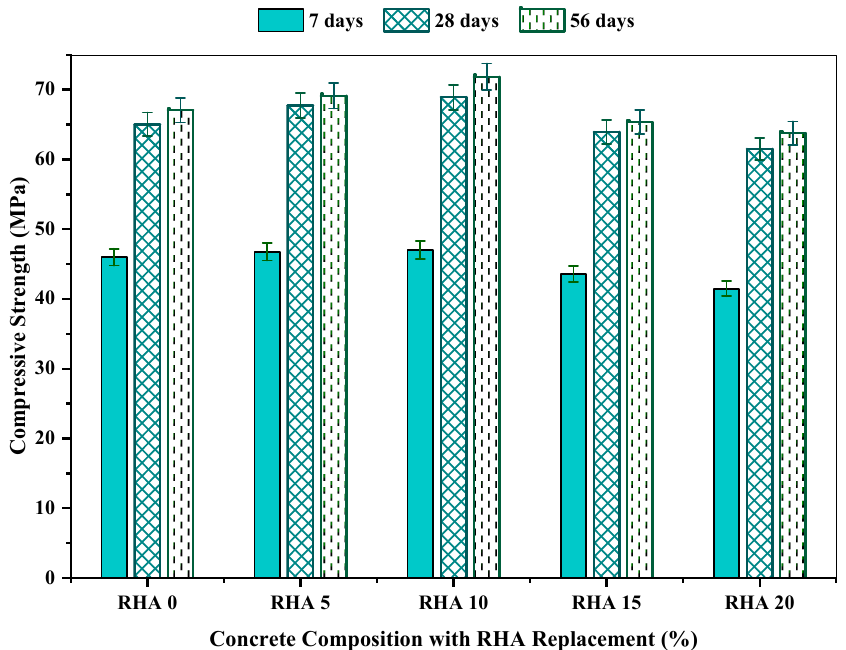
Figure 7. Compressive strength of concrete mixes incorporating RHA at 7, 28, and 56 days.